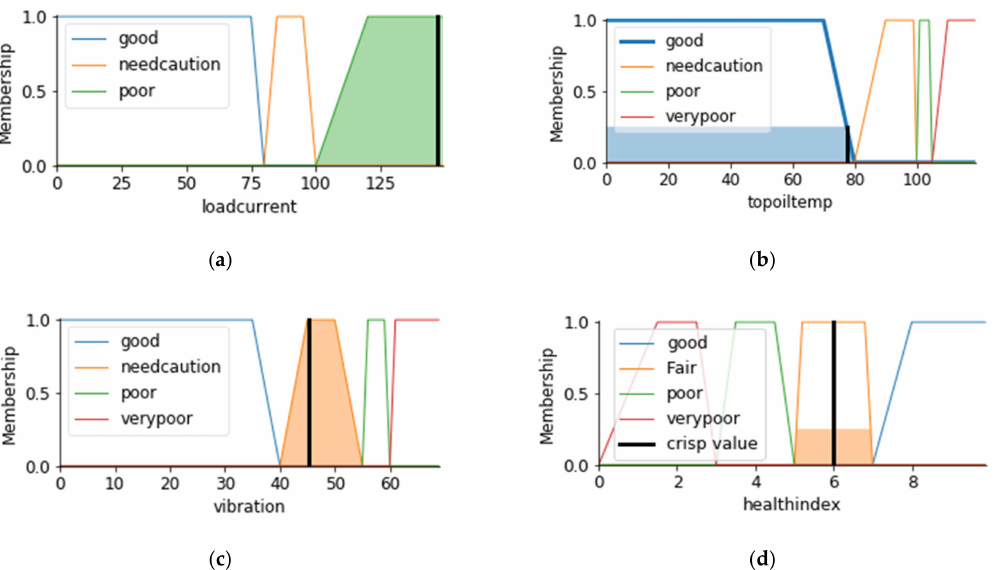
Figure 7. An example of Fuzzy control system operation. ( a ) Fuzzy membership inputs of transformer loading; ( b ) Fuzzy membership inputs of top oil temperature; ( c ) Fuzzy membership inputs of vibration; ( d ) Fuzzy membership output of Health